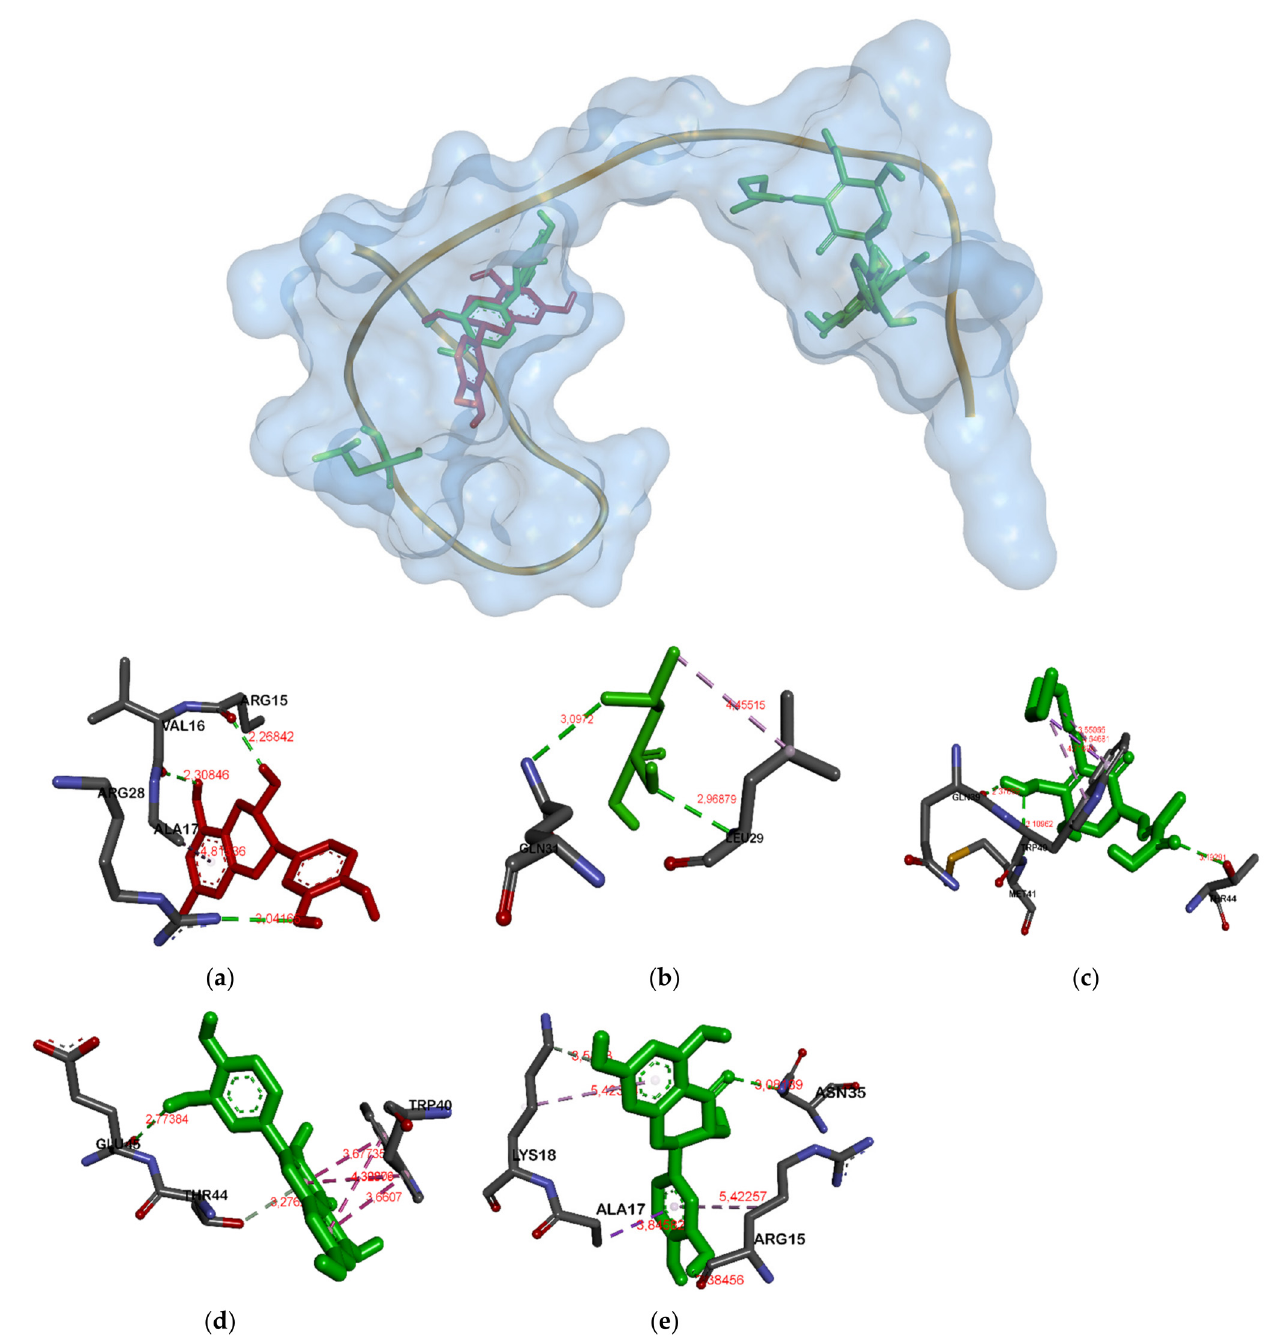
Figure 3. Binding site on GBAP for catechin ( a ), fosfomycin ( b ), ambuic acid ( c ), quercetin ( d ) and taxifolin ( e